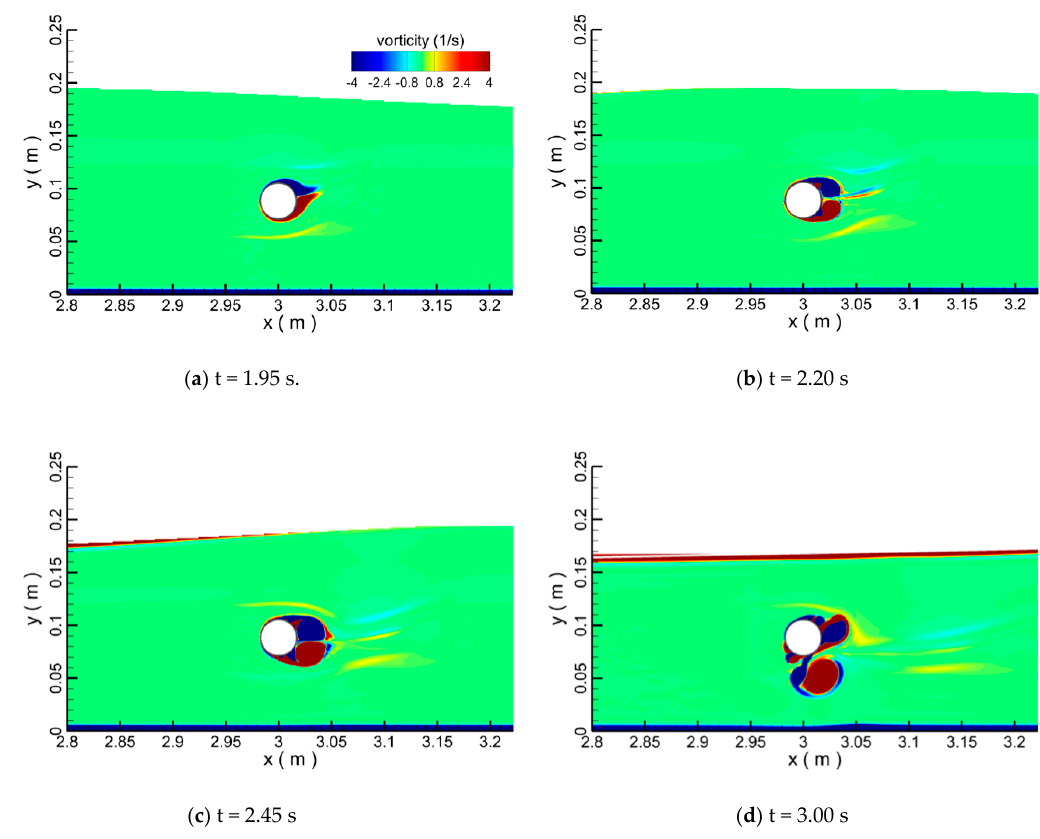
Figure 4. Snapshots of vorticity contour of the flow field at different times for run 1.